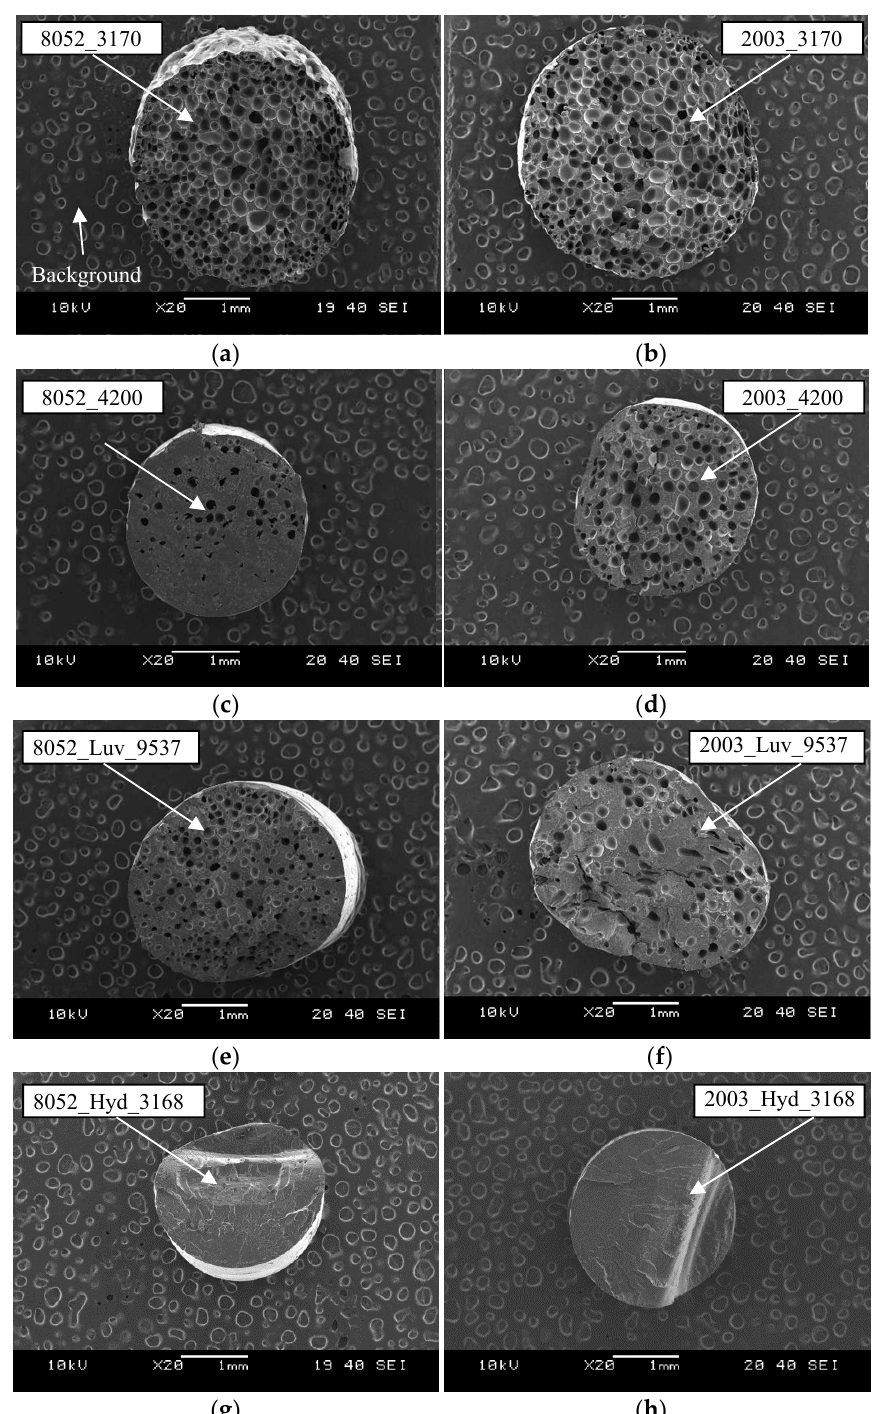
Figure 8. Scanning electron microscopy (SEM) images of samples foamed with different foaming agents (manufactured at 190 °C) ( a ) 8052_3170, ( b ) a 2003_3170, ( c ) 8052_4200, ( d ) 2003_4200, ( e ) 8052_Luv_9537, ( f ) a 2003_Luv_9537, ( g ) 8052_Hyd_3168, ( h ) 2003_Hyd_3168 20× magnification.